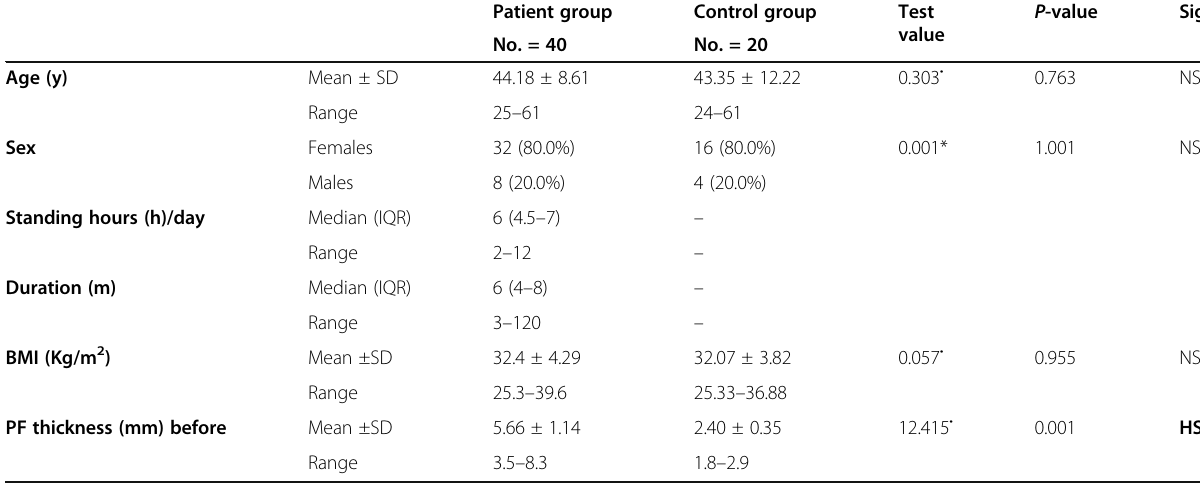
Table 1 Clinical characteristics of calcaneal spur patient group and control group